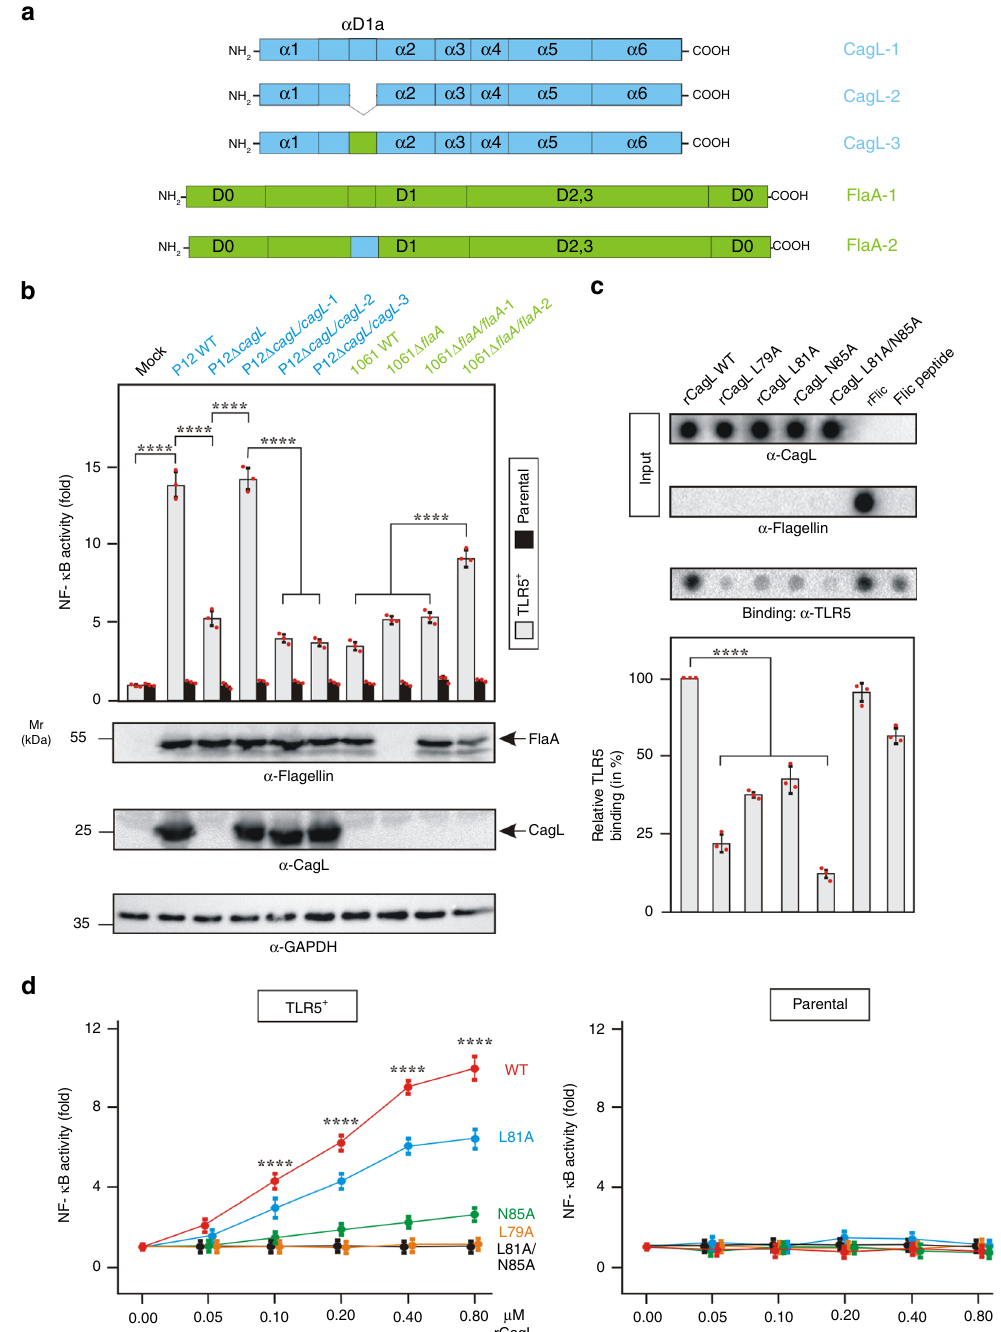
Fig. 3 H. pylori CagL contains a fl agellin-mimetic motif that interacts with TLR5. a Schematic representation of CagL and FlaA Hp produced by deletion or swapping of the α D1a motif. b TLR5 + HEK293 cells were infected with the indicated H. pylori strains expressing the constructs shown in A, followed by quanti fi cation of NF- κ B activity. c Protein binding assay. The indicated recombinant CagL proteins, FliC protein and FliC peptide as control were immobilized on Dotblots, followed by incubation with recombinant TLR5. Site-directed mutagenesis in the D1-motif of CagL reveals its importance in TLR5 binding as quanti fi ed densitometrically. d Dose-response curves of NF- κ B activity in TLR5 + and parental cells treated with the indicated amounts of CagL proteins. EC 50 value of WT CagL was determined to be 172.6 nM by using AAT Bioquest (https://www.aatbio.com). Mutations in the CagL D1-motif con fi rm its function in TLR5 activation. The CagL WT values are signi fi cant over all mutants as indicated. Quantitative data are shown as means ± SD. **** p < 0.0001 (one-way ANOVA). Each red dot represents a single data point. Source data are provided as a Source Data fi